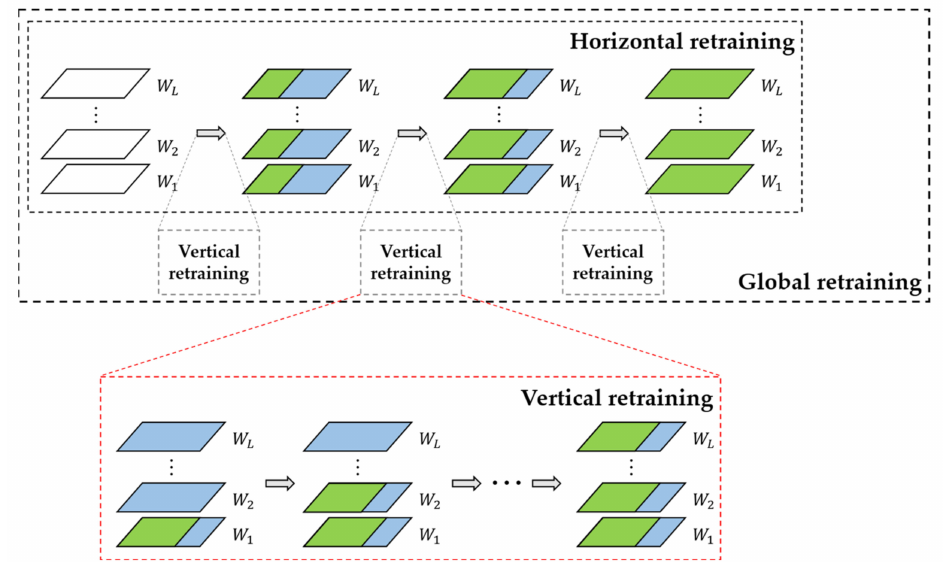
Figure 4. Global-based retraining process. W l denotes the weight set of layer l , the green areas denote the quantized low-precision weight sets, and the blue areas denote the full-precision weight sets used for